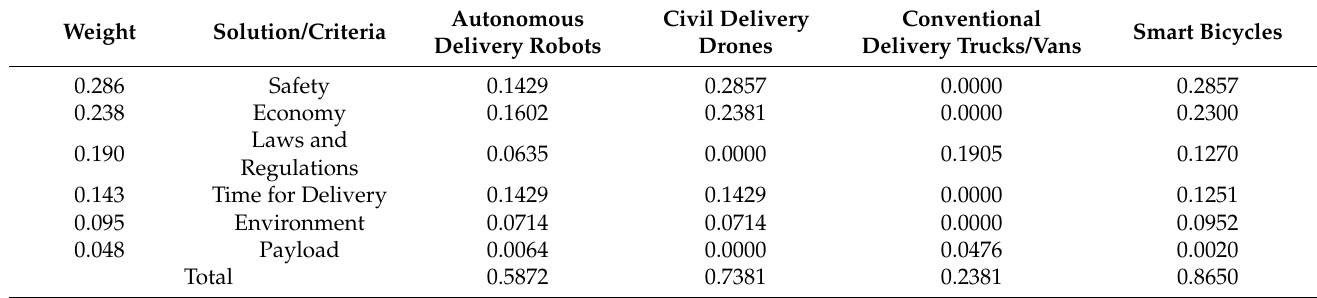
Table 12. Total scores, rank sum method—in the case of